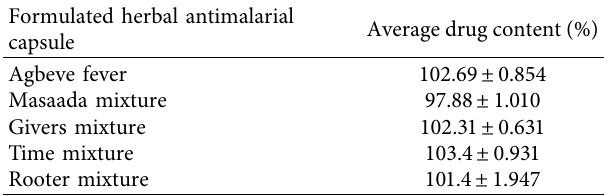
Table 6: Drug content of formulated capsules. Formulated herbal